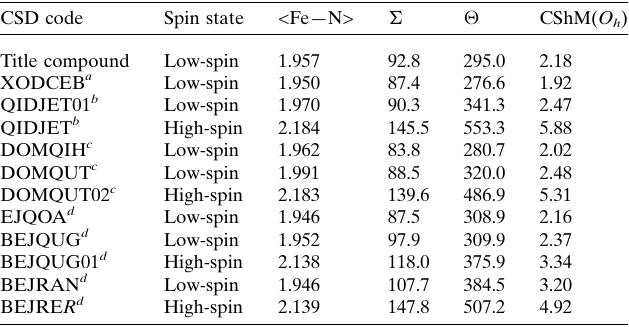
Table 2 Computed distortion indices (A˚ , (cid:4) ) for the title compound and similar literature complexes.